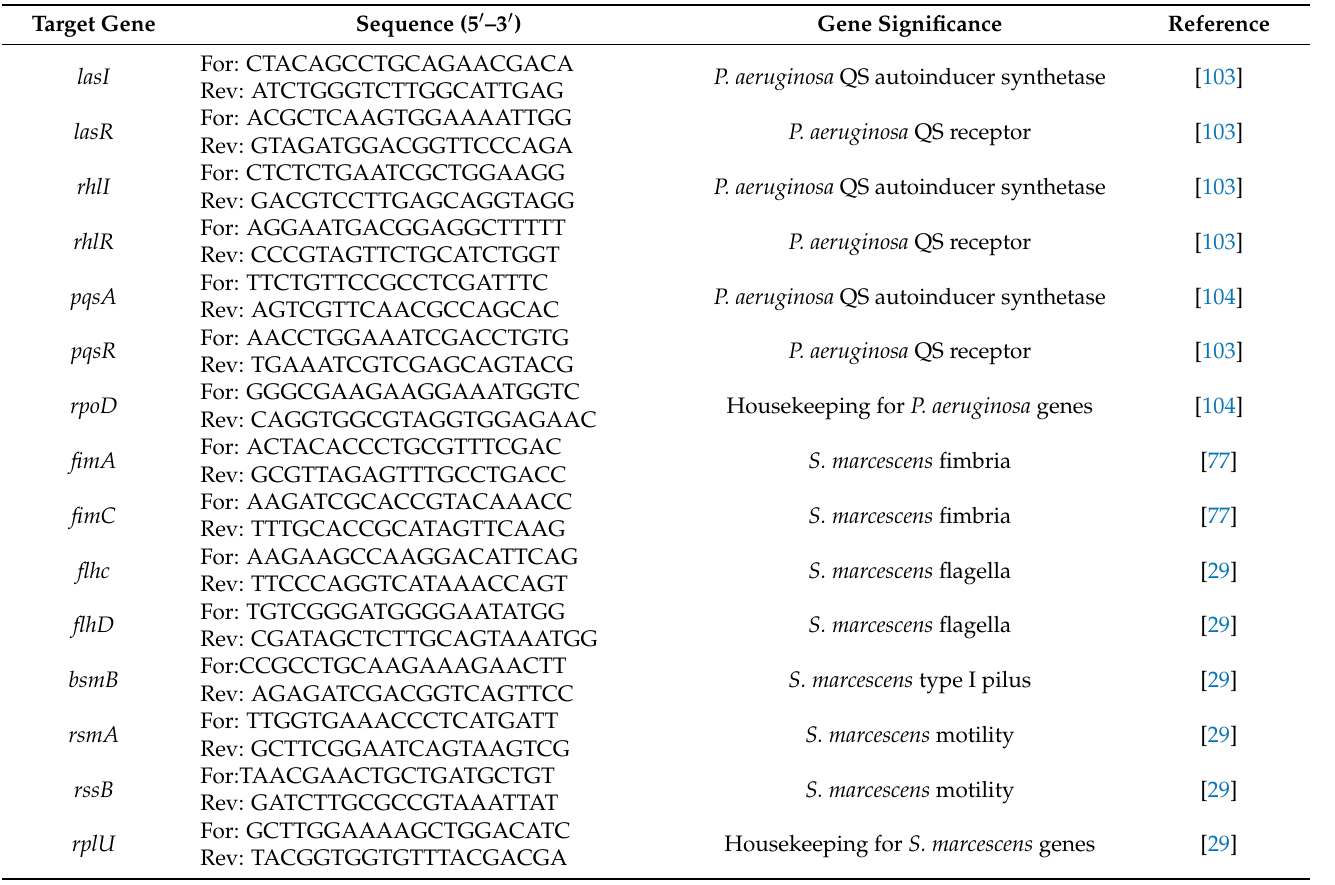
Table 4. The primers used in this